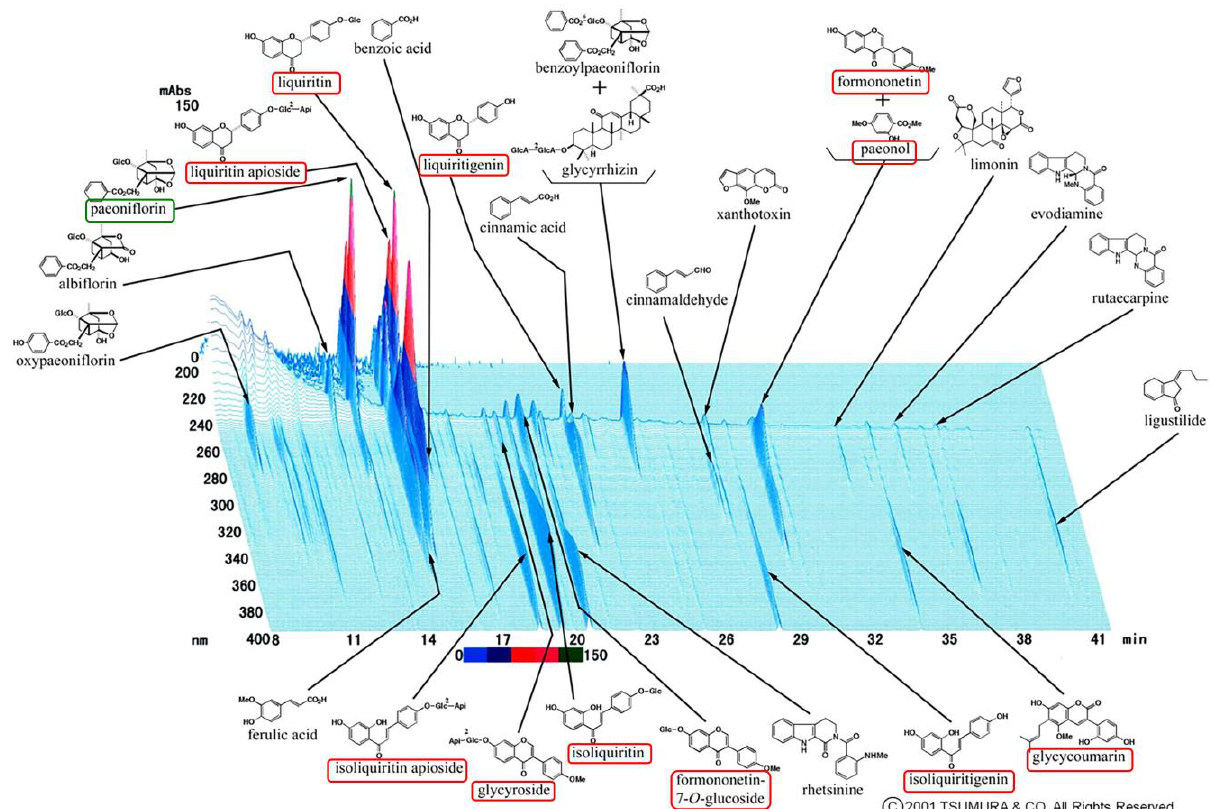
Figure 7. The 3D-HPLC pattern of Unkeito (UKT). The green box shows paeoniflorin, which is a type of terpene glycoside. The red boxes show the active estrogenic components, which are derived from the herb’s or interherb’s new metabolites, i.e., liquiritin apioside, liquiritin, liquirtigenin, formononetin + paeonol, isoliquiritin apioside, glycyroside, isoliquiritin, formononetin-7-O-glucoside, isoliquiritigenin, and glycycoumarin.